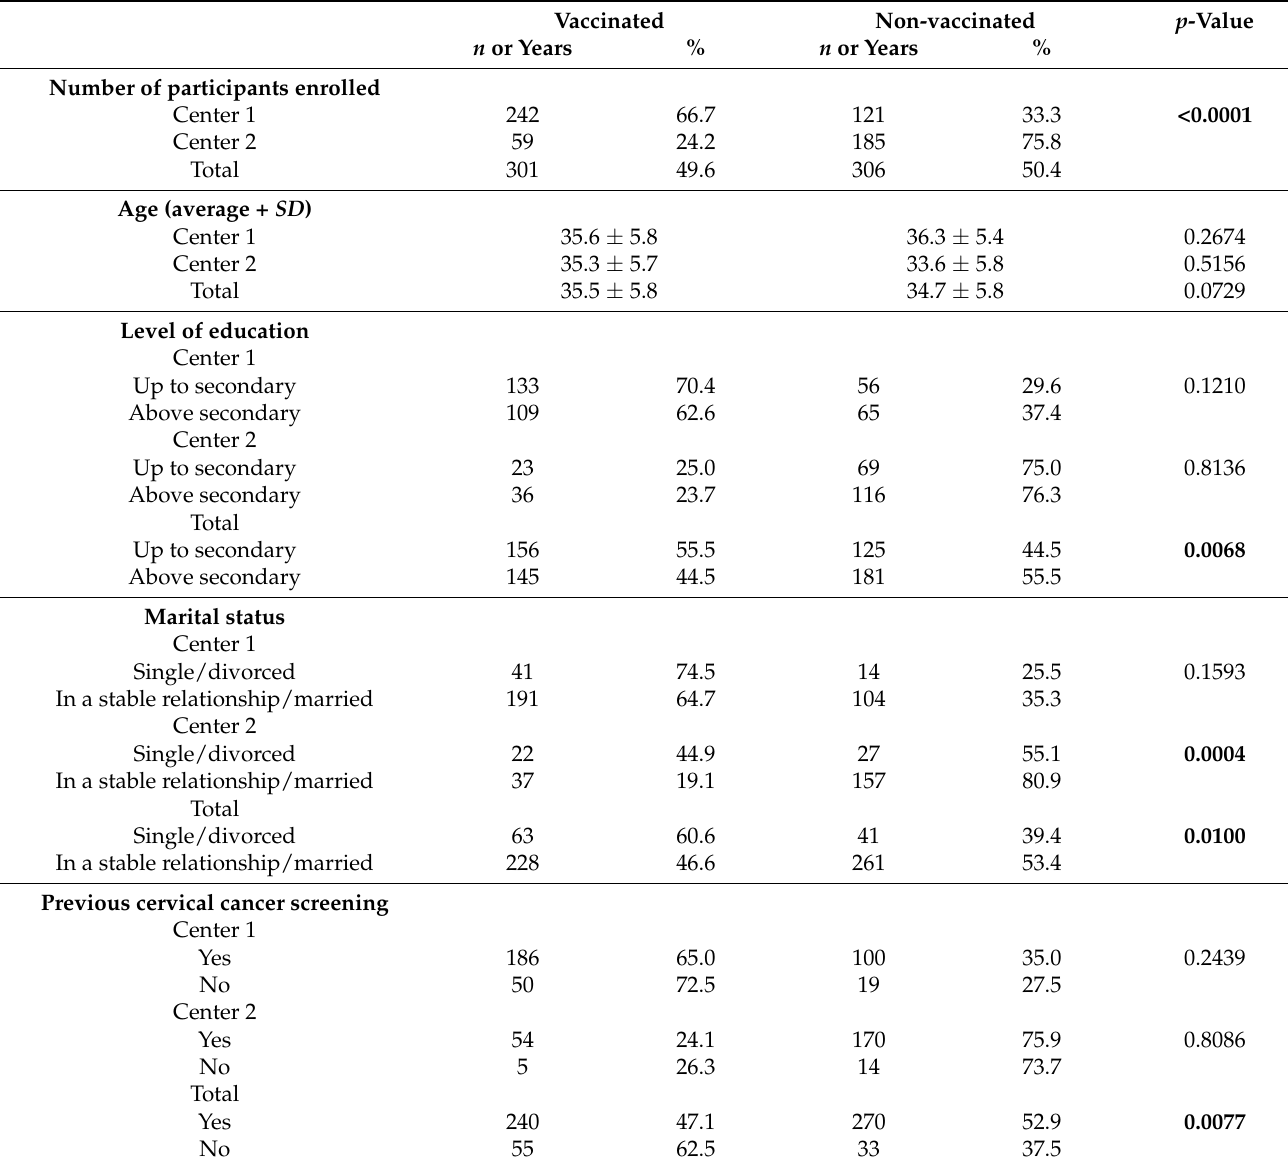
Table 1. The main characteristics of the Slovenian study participants in the COHEAHR-WP4 study ( n = 607) separated according to the decision to vaccinate against HPV or not. Values p ≤ 0.05 were considered statistically significant (marked in